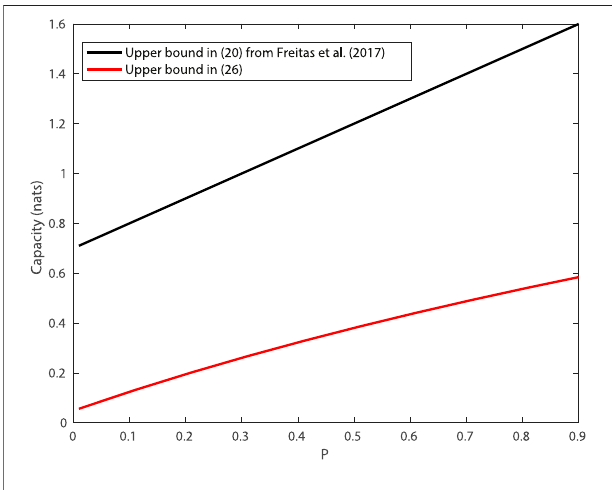
FIGURE 2 | Capacity of symmetric α -stable noise channels subject to the constraint E [ | X | ] ≤ P , with c N (cid:3) 0.01 and α (cid:3)